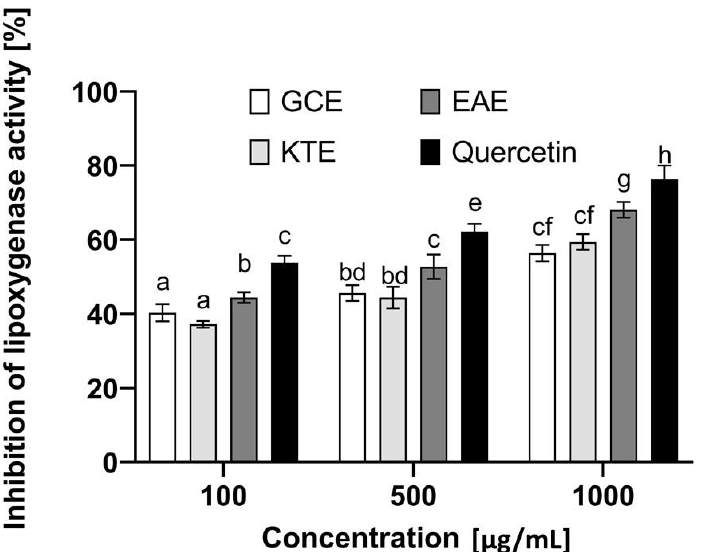
Figure 15. Influence of Centella asiatica L. (GCE), Clitoria ternatea L. (KTE) and Epilobium angustifolium L. (EAE) extracts on lipoxygenase inhibition. Data are the mean ± SD of three independent experiments, each of which consists of two replicates per treatment group. Different letters on the charts indicate significant differences between groups ( p < 0.05).